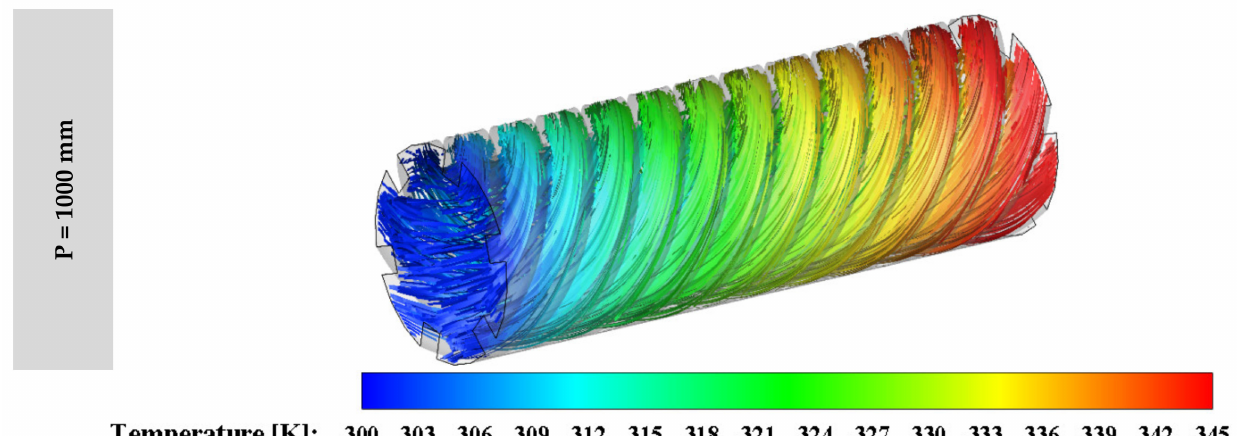
Figure 16. The streamline with contours of temperature for various models.